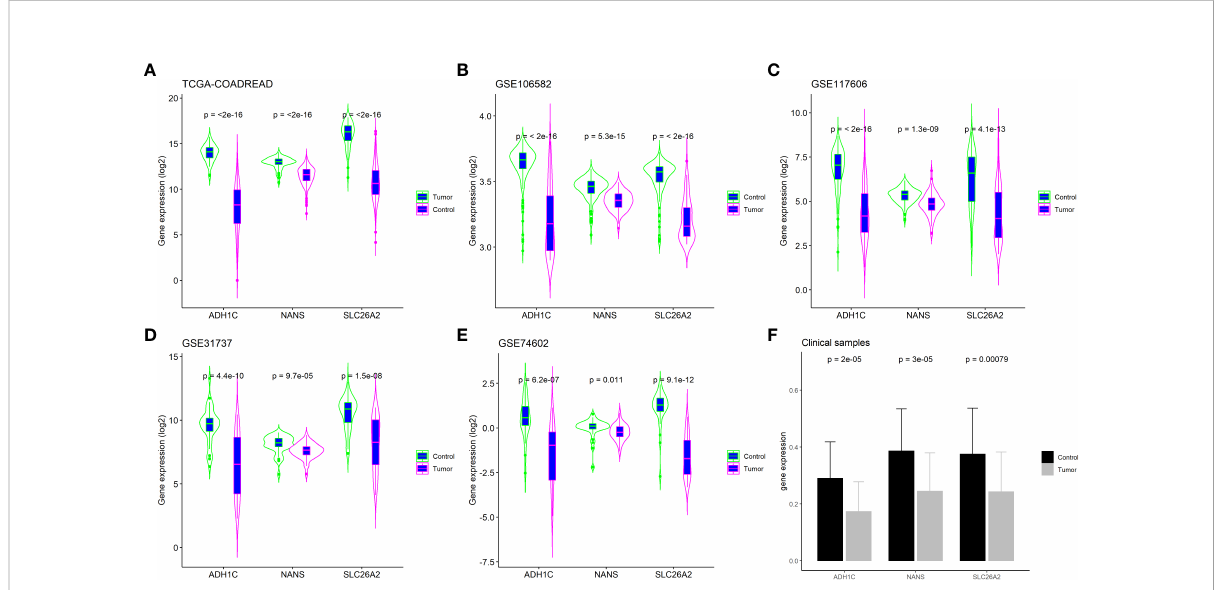
FIGURE 7 Validation key genes expression in external cohorts and clinical samples. (A) TCGA-COADREAD dataset; (B) GSE106582 dataset; (C) GSE117606 dataset; (D) GSE31737 dataset; (E) GSE74602 dataset; (F) Clinical samples by RT-PCR assay.